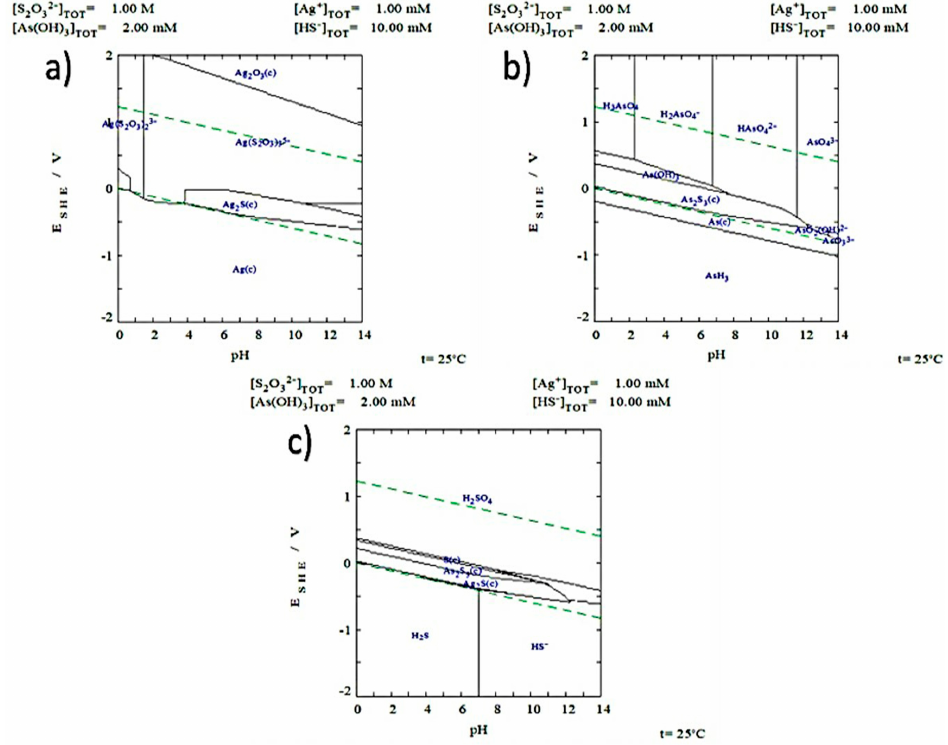
Figure 3. ( a ) Eh ‐ pH diagram for the Ag ‐ S 2 O 32 − ‐ H 2 O system at 25 °C; ( b ) Eh ‐ pH diagram for the As ‐ S 2 O 32 − ‐ H 2 O system at 25 °C; ( c ) Eh ‐ pH diagram for the S ‐ S 2 O 32 − ‐ H 2 O system at 25 °C.